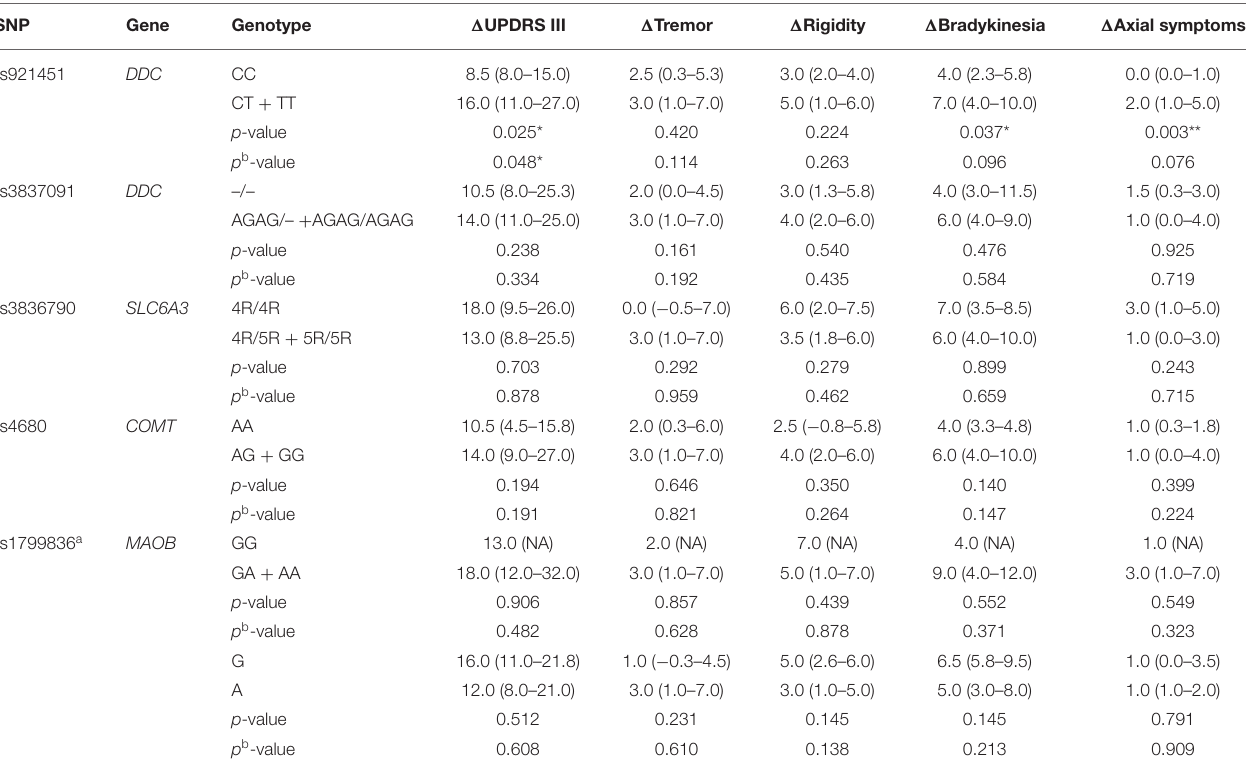
TABLE 3 | Effect of genotypes on the improvement of UPDRS motor score following administration of L-DOPA in recessive models. SNP